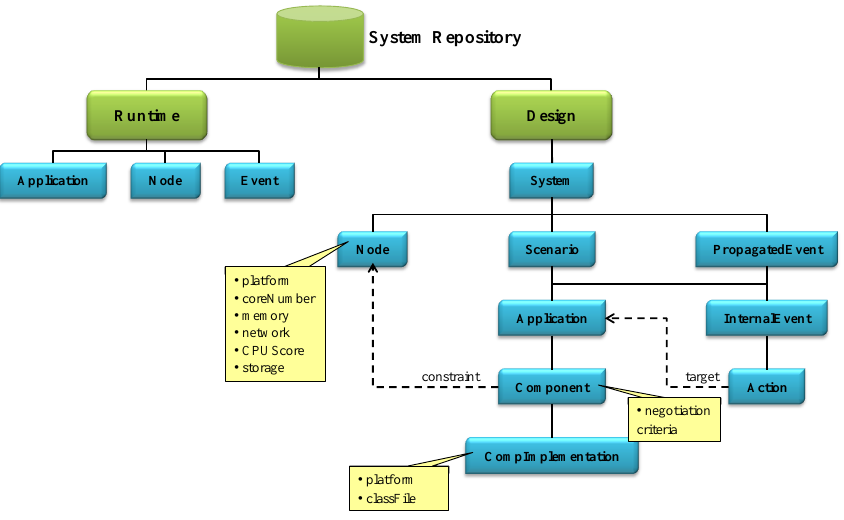
Figure 6. Structure of the System Repository at the Middleware Manager (MM) module.